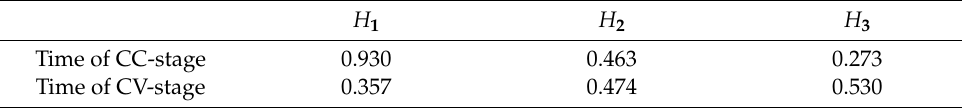
Table 1. Indicator assessment levels and reference value. H 1 H